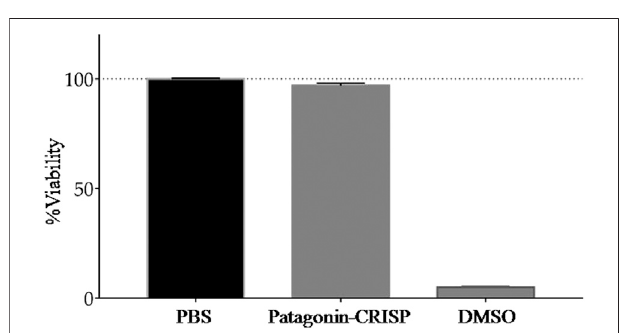
FIGURE 4 | Cytotoxicity analysis. MTT assay analysis of patagonin- CRISP against VERO cell line did not demonstrate signi fi cant cytotoxicity at < 120 μ g/ml